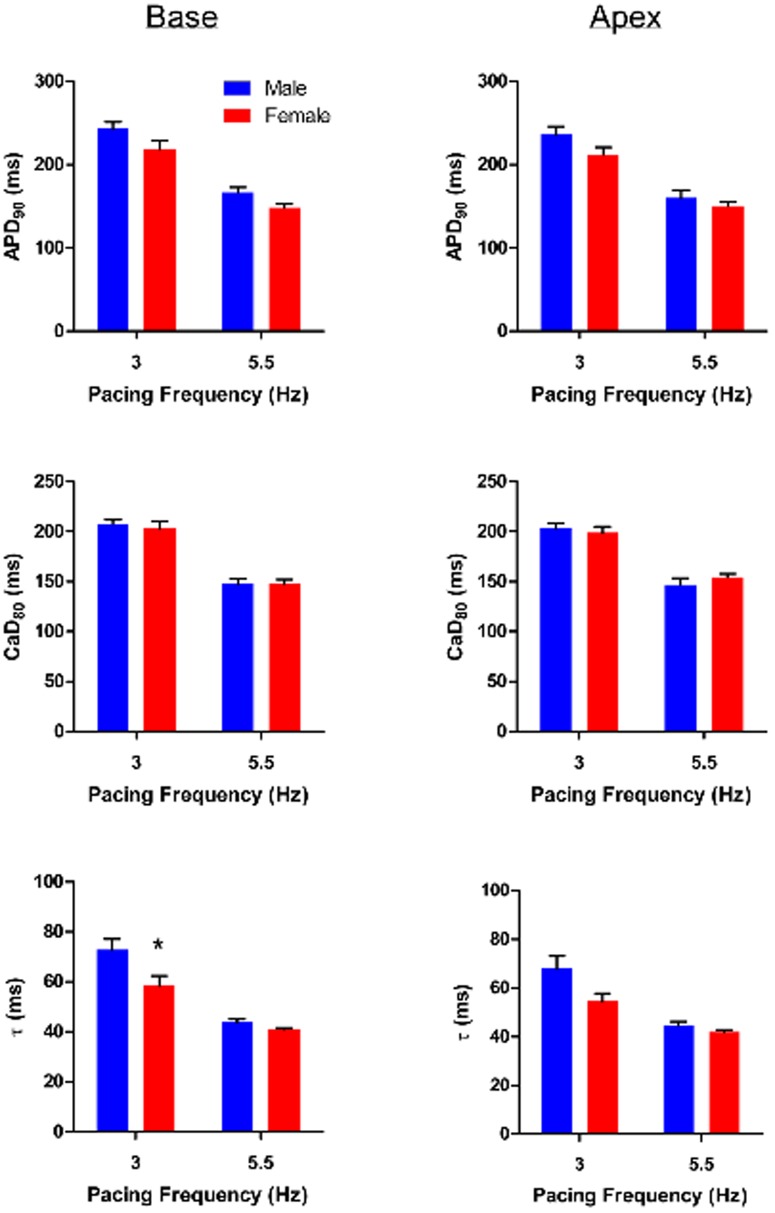
Baseline sex differences in steady-state ventricular APs and CaTs.Summary data for action potential duration (APD90, ms), calcium transient duration (CaD80, ms) and the time constant of calcium recovery (τ, ms) at 3 and 5.5 Hz pacing at either the LV base (left) or apex (right) in the absence of β-adrenergic stimulation (baseline). *p<0.05, female vs male.